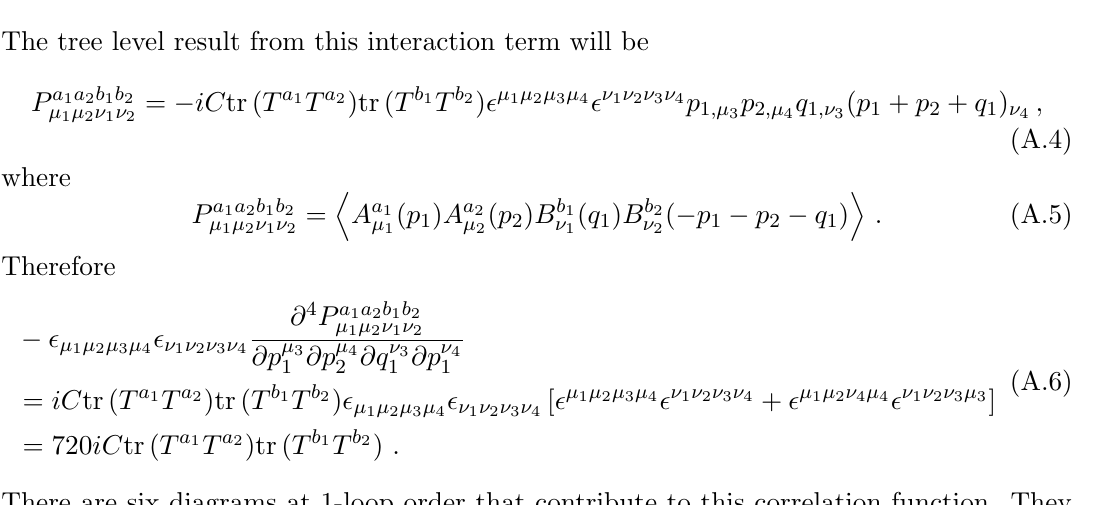
Figure 9 . The six diagrams that contributes to the 4 gluon interaction. Here A i (cid:17) A a i B i (cid:17) B b i ( q i ) with q 2 = (cid:0) p 1 (cid:0) p 2 (cid:0) q 1 (cid:23) i